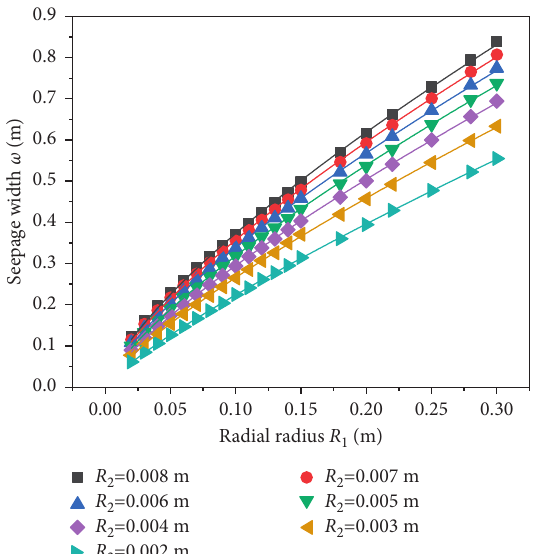
Figure 14: Radial flow and parallel flow models.